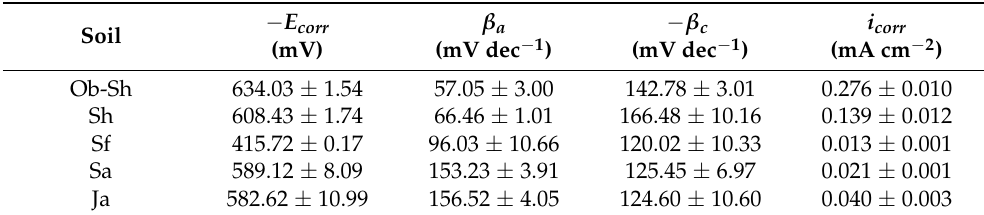
Table 5. PDP parameters for the corrosion of CSX36 specimens in the studied Jeddah soil solutions at 30 ± 1 ◦ C.